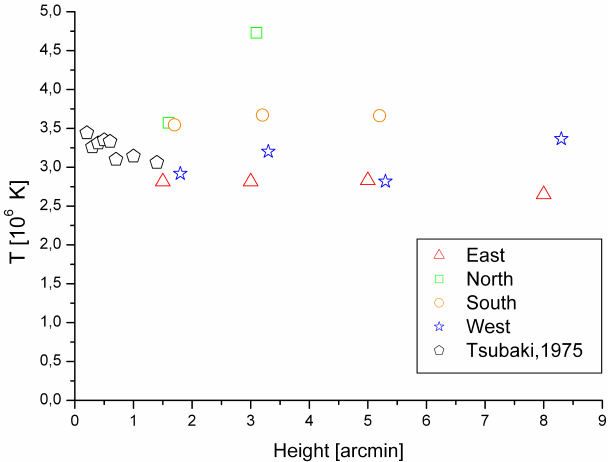
Figure 7 Fig. 7. As in Fig. 6, but now considering the Doppler temperatures (effective ion temperatures) computed from the line widths. Note the excellent agreement with the Tsubaki (1975) values when con- sidering the same radial distances and only equatorial Figure 5 Fig. 5. Radial variations of the 530.3-nm Fe XIV coronal central line average intensities for different directions (see Fig. 1). Units are the same as in Fig. 4 and intensities are averaged over the whole length of the slit shown in Fig. 1. Bars of uncertainty correspond to the dispersion of the intensities measured over the length of the slit; the level of the noise is always smaller.